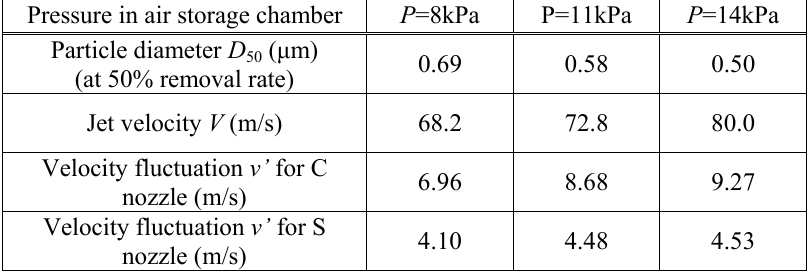
Table 1 Particle diameters at 50% removal rate for each storage tank